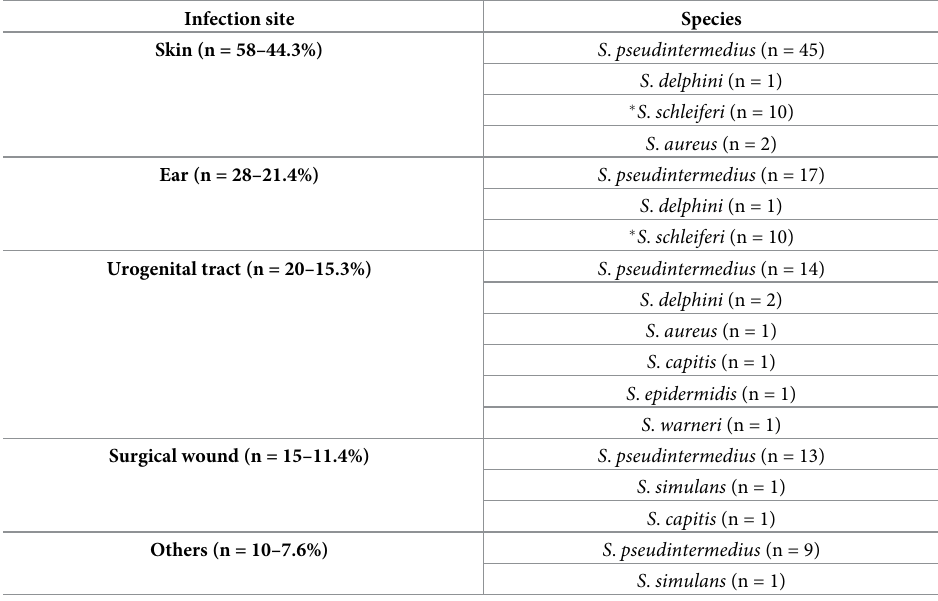
Table 1. Distribution and proportion of staphylococci species isolated from different sites of sampling from 116 dogs at two different veterinary clinics from Belo Horizonte, Brazil, between 2017 and